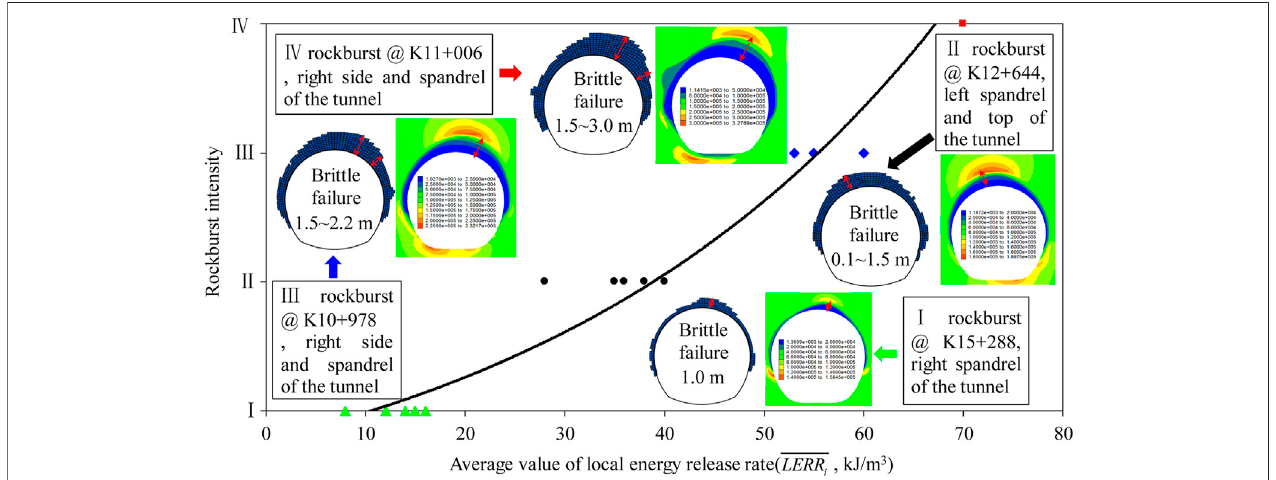
FIGURE 11 | Relationship between the average value of local energy release rate ( (cid:1) LERR i ) and rockburst intensity.